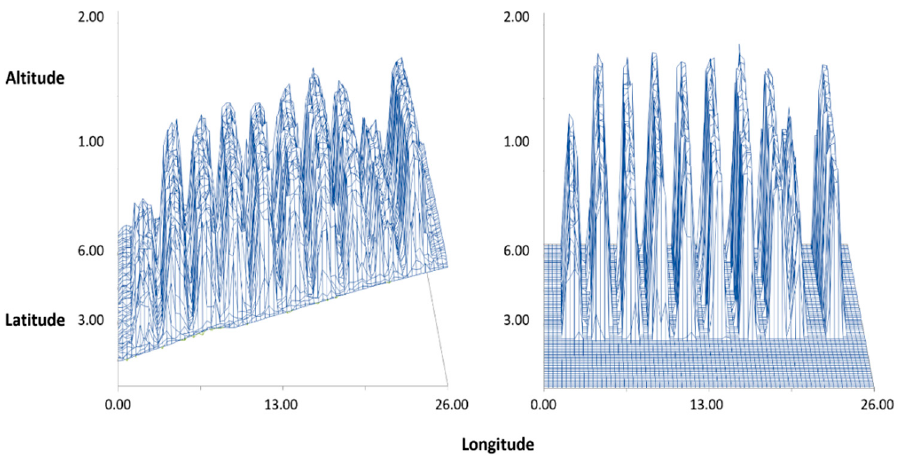
Figure 1. Representations of point cloud data. Subsets of point cloud data describing field N-6 are used to fit the wireframe surface plots shown here on the left, depicting the artifactual slope that formed primarily along the x-axis as a result of image processing without global positioning system (GPS) control points. This slope is marginalized by including the x- and y-axes as covariates in an analysis of covariance (ANCOVA), as shown on the right in a plot of residuals after accounting for variation associated with x- and y-axes.